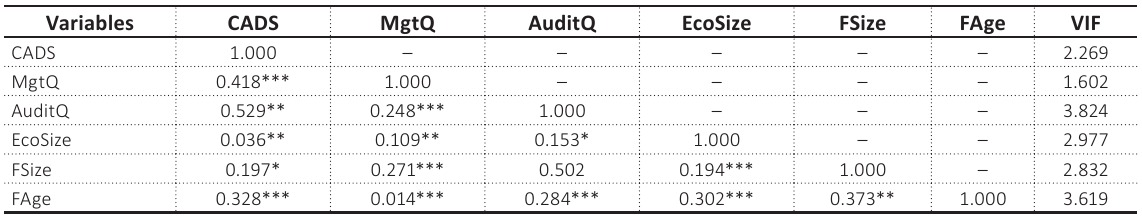
Table 2. Correlation matrix and